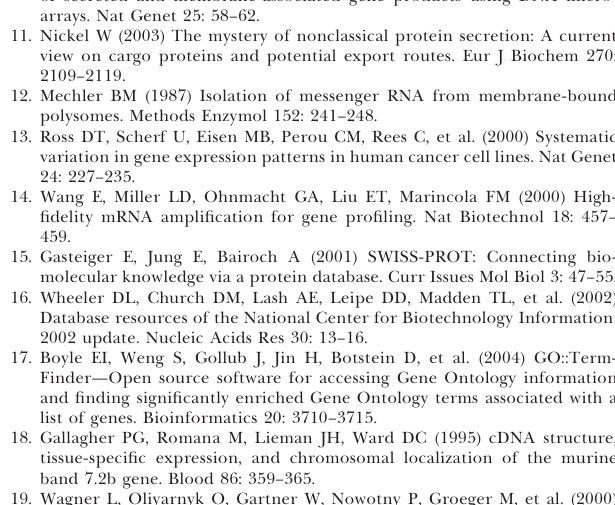
Table S1. List of Cell Lines Used in This Study The table lists the tissue of origin for each line and its ATTC catalog number (where available). Table S2. Gene Ontology (GO) Category Enrichment among MS Genes with Unexpected Subcellular Localization Overrepresentation of GO annotations among characterized MS genes, whose transcripts were enriched in the cytosolic fraction compared to all characterized MS genes, is shown. Corrected p -values were calculated using